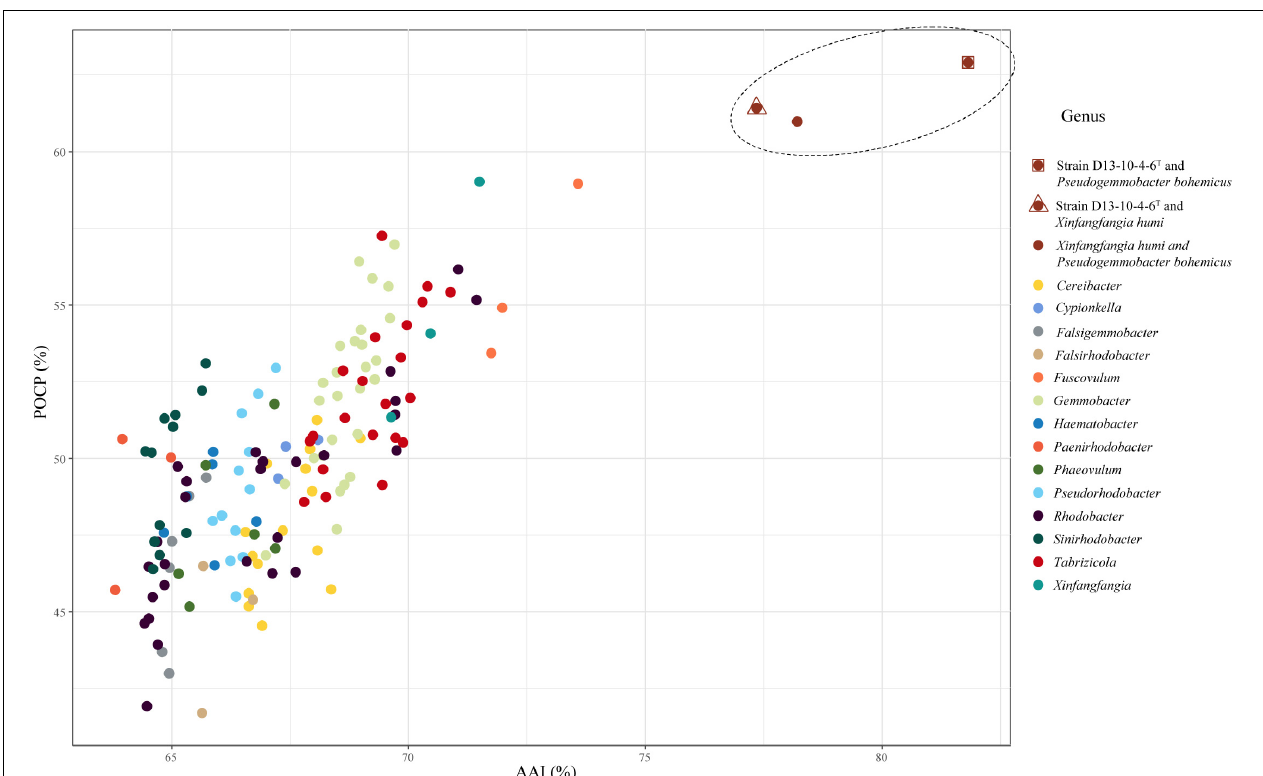
FIGURE 4 | The relationship of AAI and POCP between strain D13-10-4-6 T , P. bohemicus Cd-10 T , X. humi IMT-291 T and the related strains in the family Rhodobacteraceae. The dots inside the dashed line represent the values between strain D13-10-4-6 T , P. bohemicus Cd-10 T and X. humi IMT-291 T , and those outside represent the values between the three strains and strains in the related genera of the family Rhodobacteraceae. A total of 52 genomes were included in this analysis.